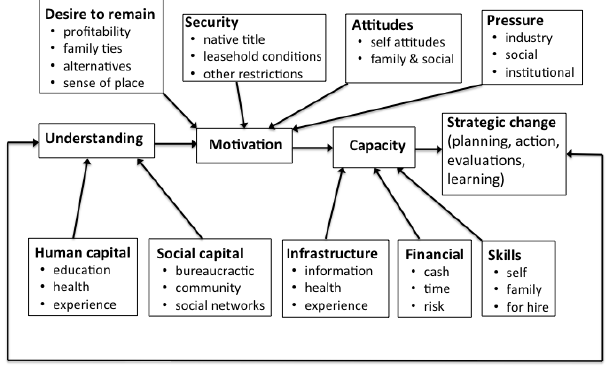
Fig. 2 . Interactions and drivers of change for strategic change in natural resource management systems (C. J. MacGregor, unpublished manuscript